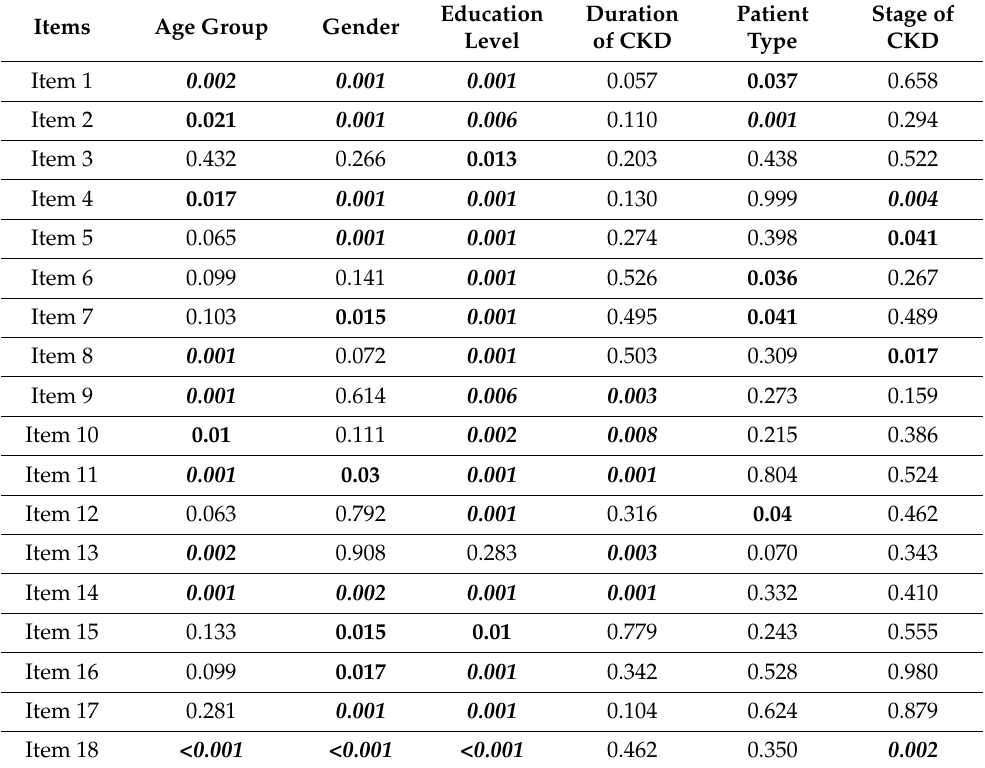
Table 6. p -Value by chi-square